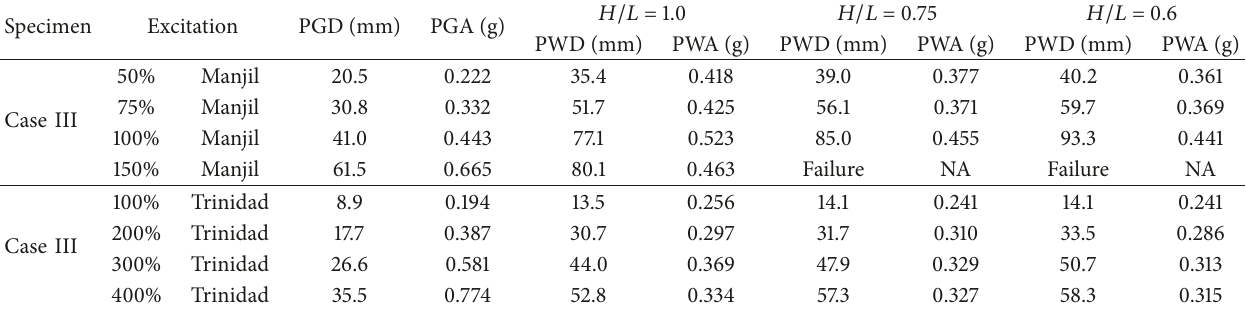
Table 5: Seismic response comparison for the considered infill walls subjected to earthquake excitations with various frequency contents. Specimen